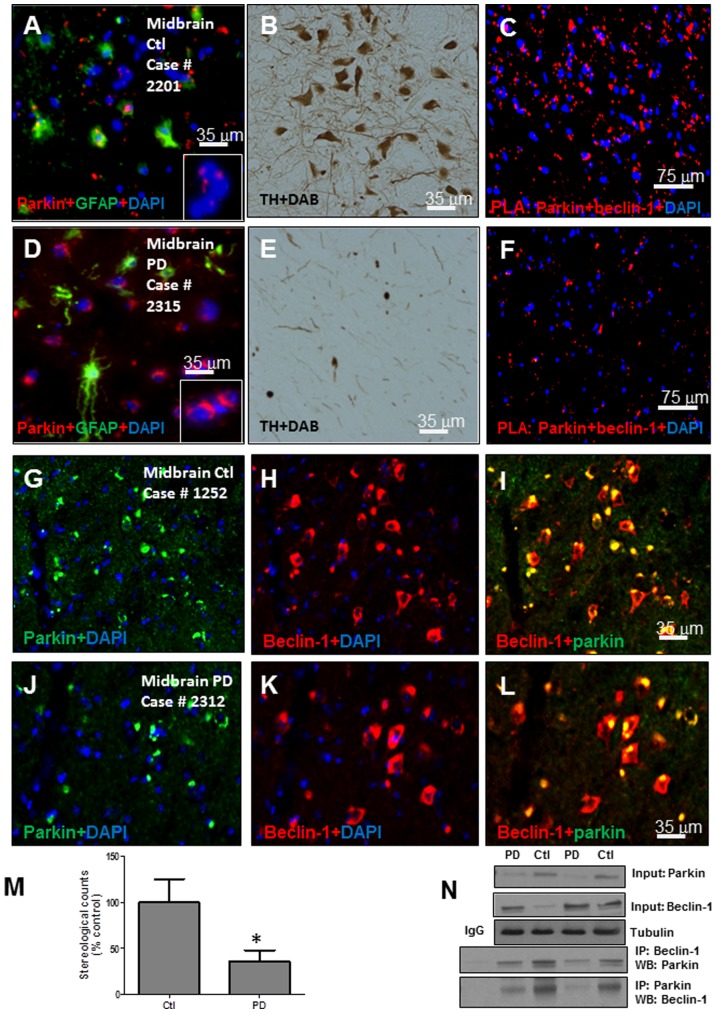
Parkin co-localizes with Beclin-1 in human brain but their interaction is decreased in sporadic PD.Immunostaining of paraffin embedded 20 µm thick human midbrain sections A) shows parkin expression in DAPI stained neurons co-labeled with GFAP. Inset is higher magnification showing parkin expression. B) TH+ neurons counterstained with DAB in serial midbrain sections of healthy human subjects. C) In situ proximity ligation assay (PLA) shows human parkin-Beclin-1 interaction in control midbrain neurons (n = 7). D) Parkin expression in DAPI stained neurons co-labeled with GFAP indicating active astrocytes. Inset is higher magnification showing cytosolic parkin accumulation. E) TH+ neurons counterstained with DAB in serial midbrain sections of post-mortem PD brains. F)
In situ PLA shows reduced human parkin-Beclin-1 interaction in midbrain neurons in PD brains (n = 9). G). parkin and H) and Beclin-1 labeling are co-localized I) in human midbrain sections (n = 7). J) shows alteration of parkin expression and K) Beclin-1 staining with L) reduced co-localization in sporadic PD brains (n = 9). M) graph represents stereological counting of C and F in situ PLA and N) WB analysis on 4−12% NuPage SDS gel showing beclin-1 levels relative to actin and immunoprecipitation in post-mortem human brain tissues. Asterisk indicates significantly different, means±SEM, ANOVA, Newman Keuls.